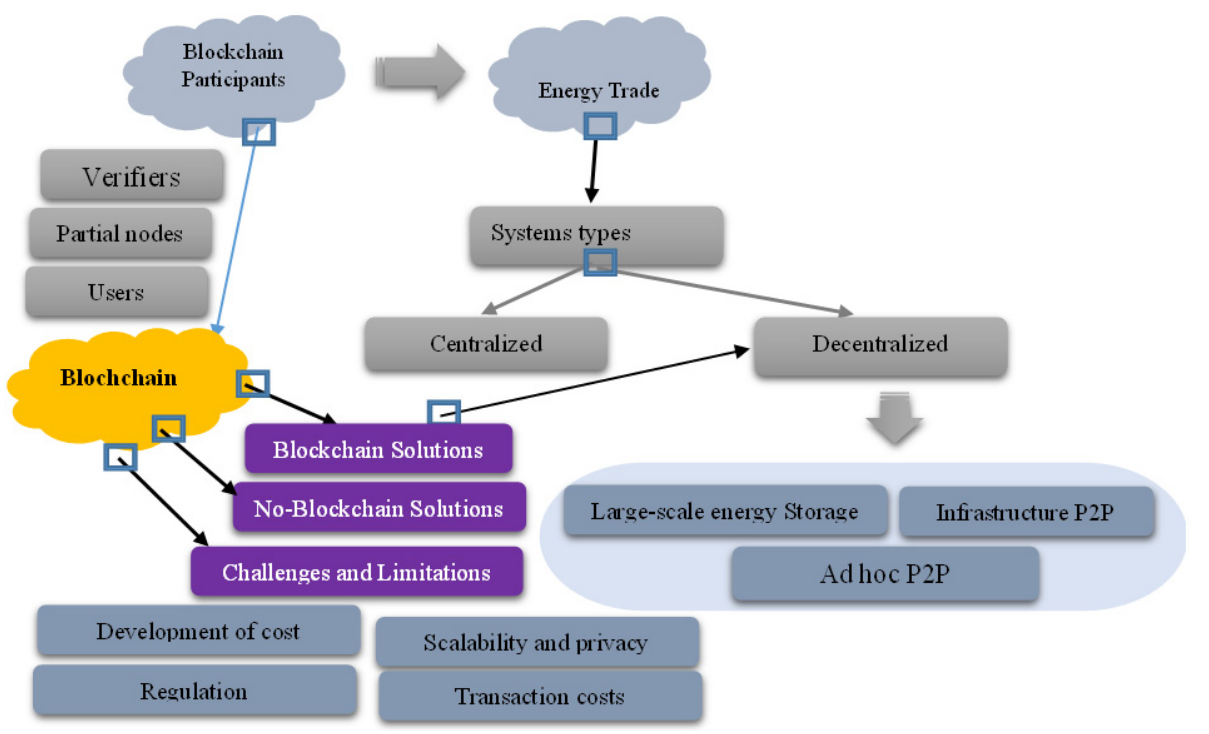
Figure 9. Blockchain P2P energy trading structure.